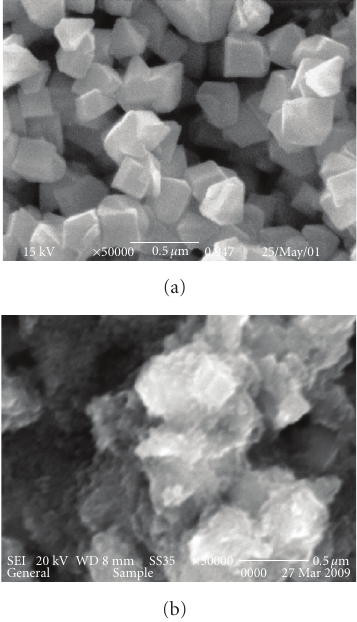
Figure 2: SEM images of the surface of TiO 2 submicron particles (400C, JGC-CCIC) (a) and a mixture of TiO 2 submicronparticles and nanoparticles (PST-400C, JGC-CCIC) (b). Magnification of each view is 50,000 redox 3